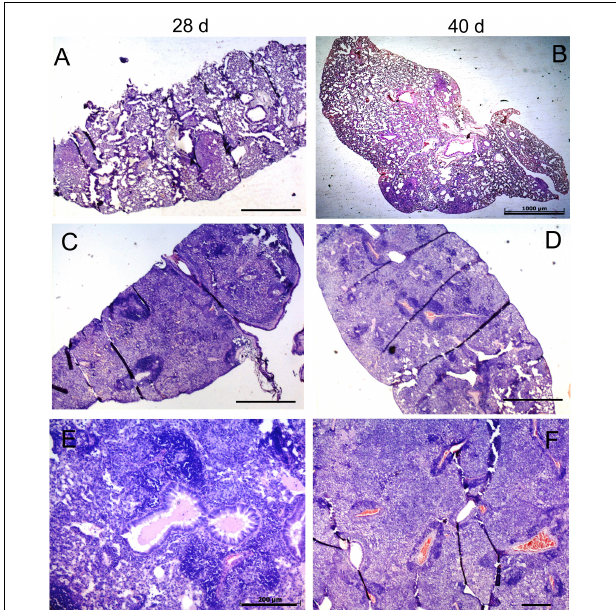
FIGURE 5 | Histopathological changes in the lungs of mice infected with low-virulence strain 6849 and high-virulence strain 8835. C57BL/6 mice were infected with strain 6849 (A,B) or strain 8835 (C–F) , and lungs were examined on day 28 (A,C,E) and day 40 p. i. (B,D,F) . Representative hematoxylin-and-eosin (H&E) -stained lung sections. Few small-size granulomas (A,B) . Extensive pneumonia, leading to consolidation of lung tissue (C–F) . Note accumulation of exudates in the respiratory bronchioles on day 28 p.i. (E) , and blood coagulation in the vessels and diffuse necrotic cell death in the lung parenchima on day 40 p.i. (D,F) . Bars, 1,000 µ m (A–D) , 200 µ m (E,F) . family), as well as genes Rv1982A/ vapB36 and Rv1982c/ vapC36